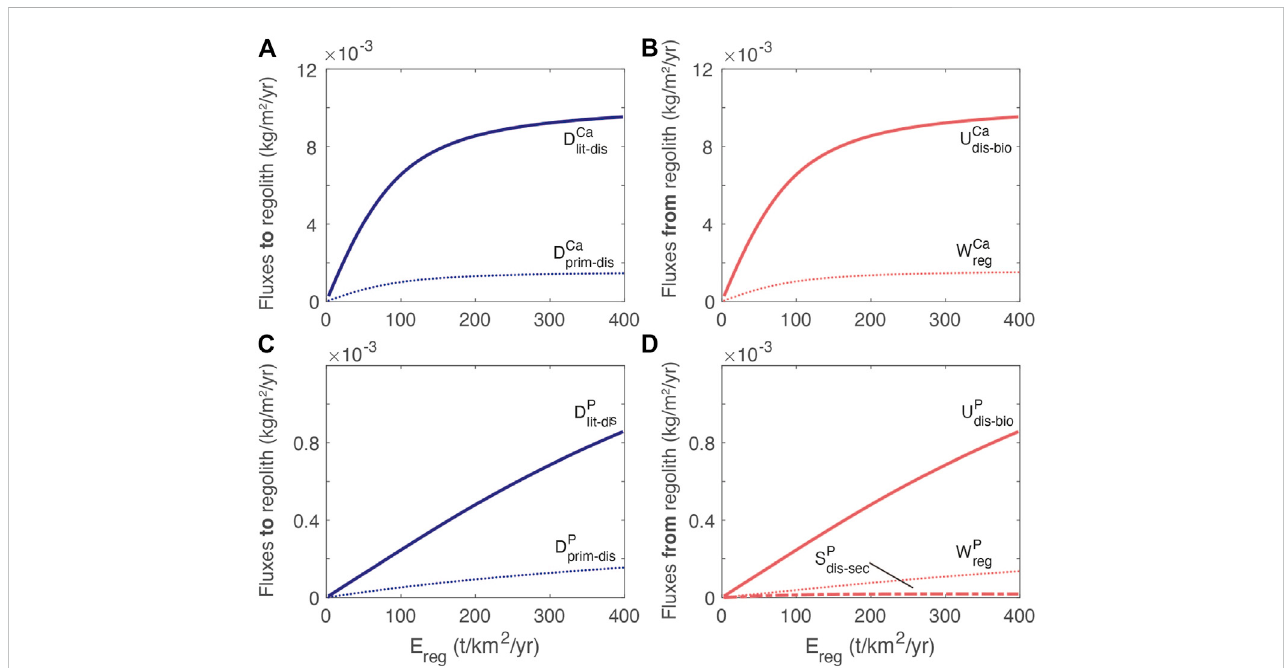
FIGURE 6 Exchanges between reservoirs. (A) Ca fl uxes into dissolved regolith pool from mineral dissolution ( D Ca prim − dis ) and litter dissolution ( D Ca lit − dis ); (B) Ca fl uxes from dissolved regolith pool due to plant uptake ( D Ca dis − bio ) and export via weathering ( W Ca reg ) (C) Corresponding P fl uxes into accessory mineral and litter dissolution; and (D) fl uxes leaving the regolith, including the net uptake into the sorbed/occluded fraction ( S P dis − sec